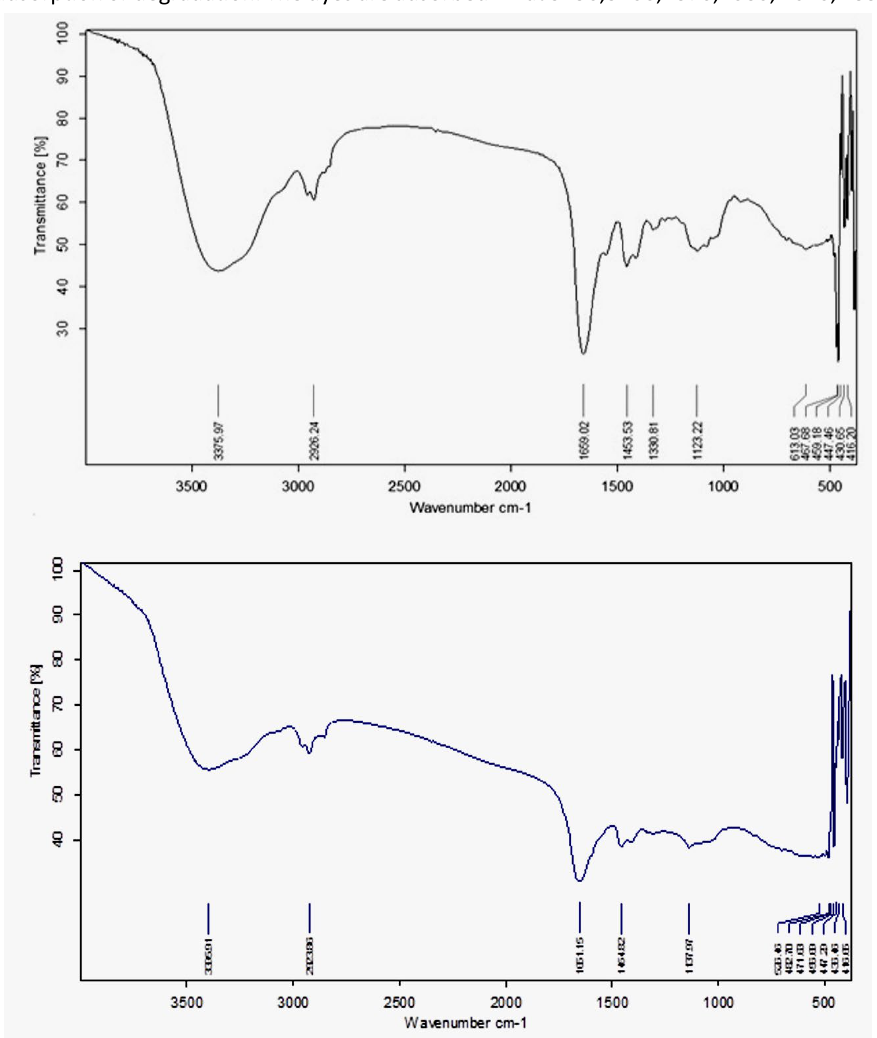
Fig. 6. FTIR spectrum of Congo red-21 (a) control dye (b) Congo red-21 dye after decolorization by immobilized